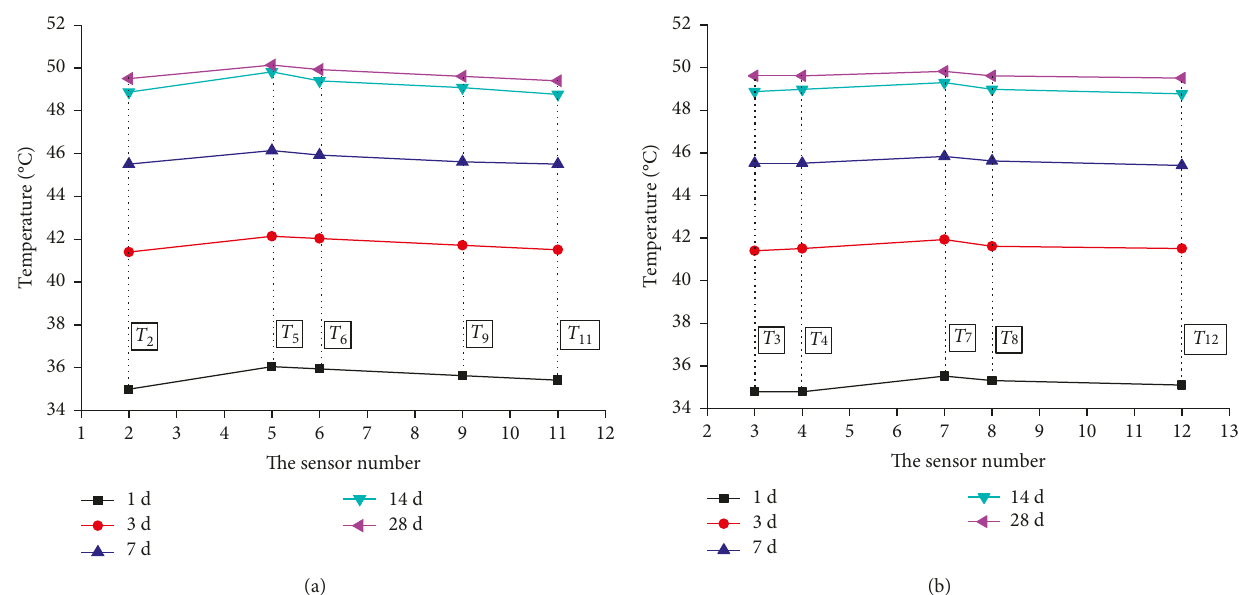
Figure 4: The temperature of the specimen C1 at different ages along the height section ( ° C). (a) The temperature near concrete core. (b) The temperature near concrete surface.